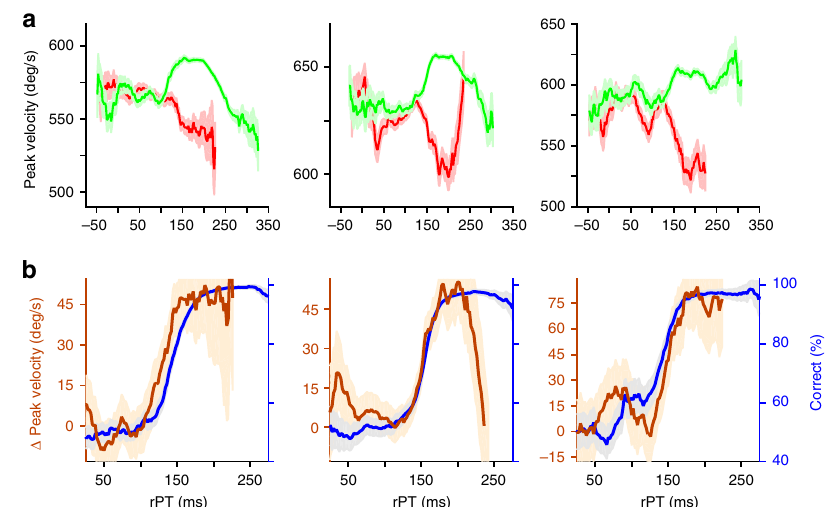
Fig. 3 Processing-time-dependent changes in peak velocity closely track perceptual performance. a Mean peak velocity (±1 s.e.m.) of correct (green) and incorrect (red) saccadic choices as a function of rPT. b Peak velocity modulation (mean correct − mean incorrect peak velocity, brown curves) and choice accuracy (tachometric curves, blue) as functions of rPT. Error bars in b represent 95% con fi dence intervals. Data are from monkeys R, T, and G (left to right) NATURE COMMUNICATIONS| (2018) 9:2907 |DOI: